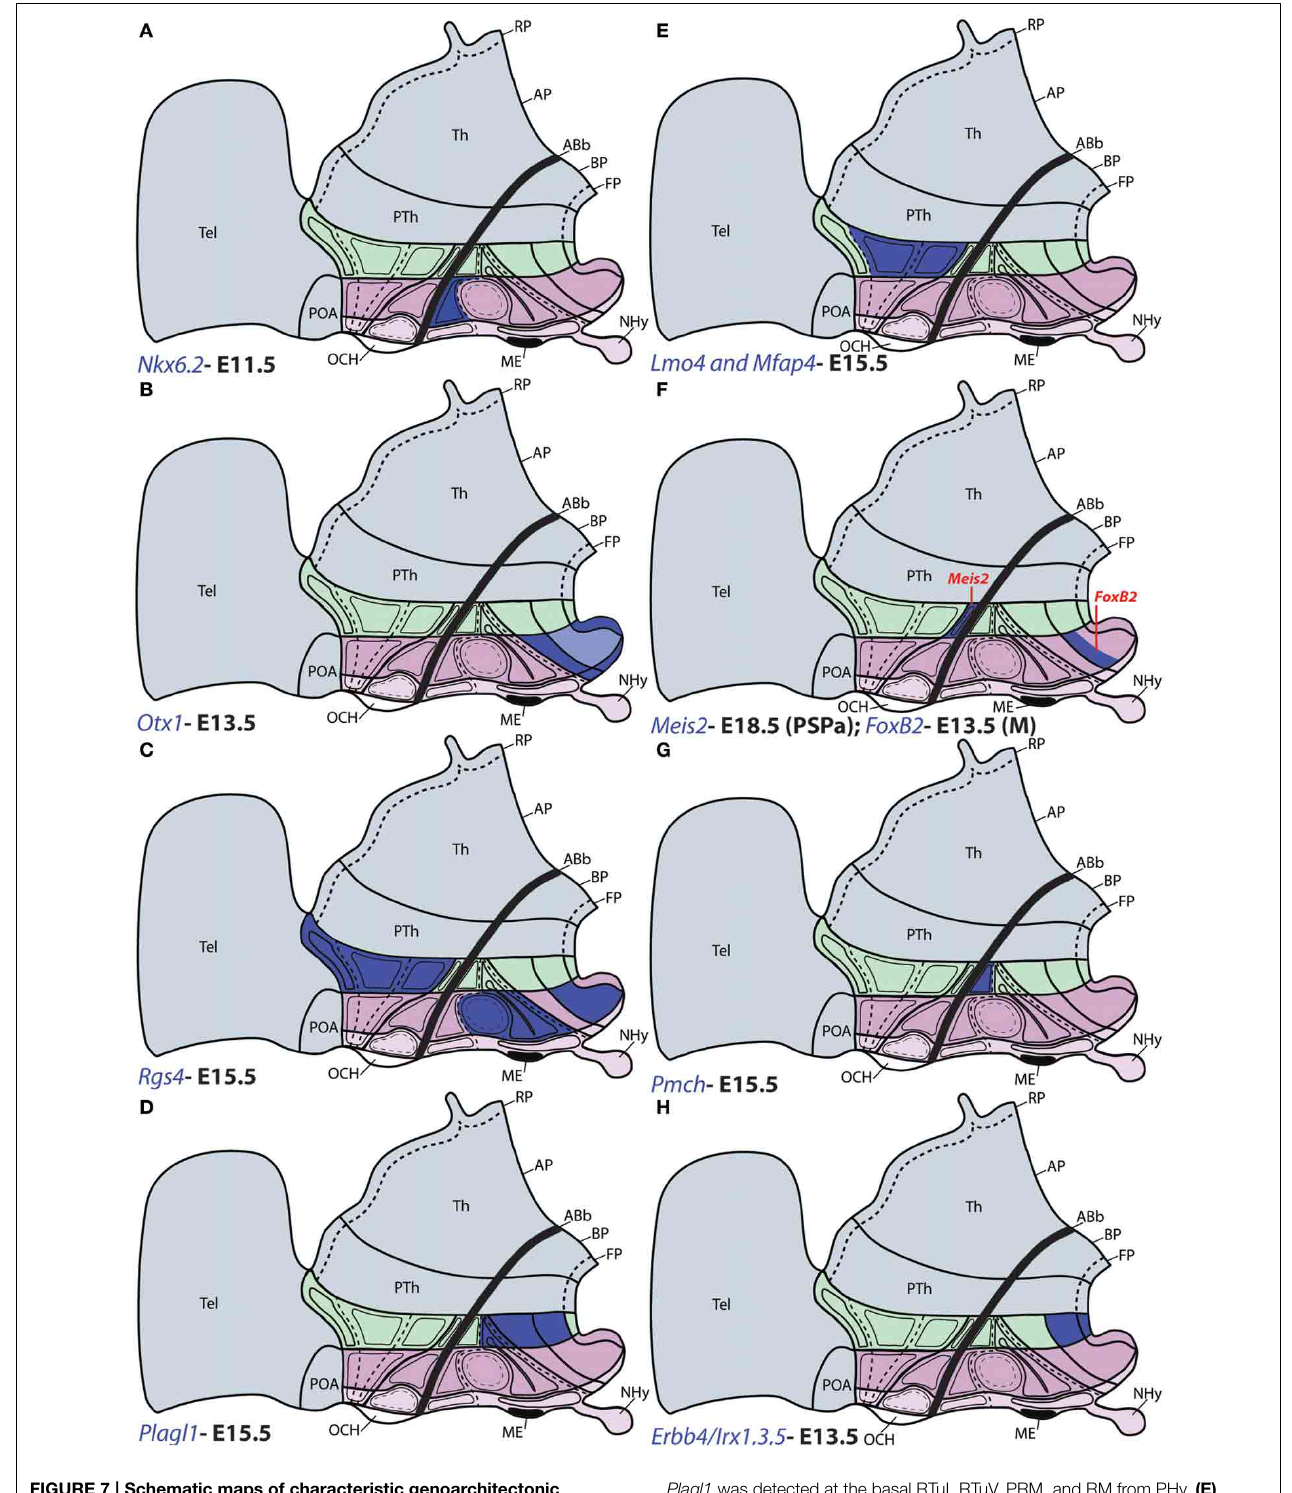
Plagl1 was detected at the basal RTuI, RTuV, PRM, and RM from PHy. (E) Lmo4 and Mfap4 were expressed selectively at the CPa and VPa paraventricular subdivisions within alar PHy. (F) Meis2 signal (red tag) was detected at the small PSPa domain; FoxB2 (red tag) was observed in a previously unknown dorsal subdivision of M domain (THy). (G) Pmch signal was detected only at the RTuD domain from basal PHy. (H) Erbb4, Irx1, Irx3, and Irx5 were detected at the RM and PHy